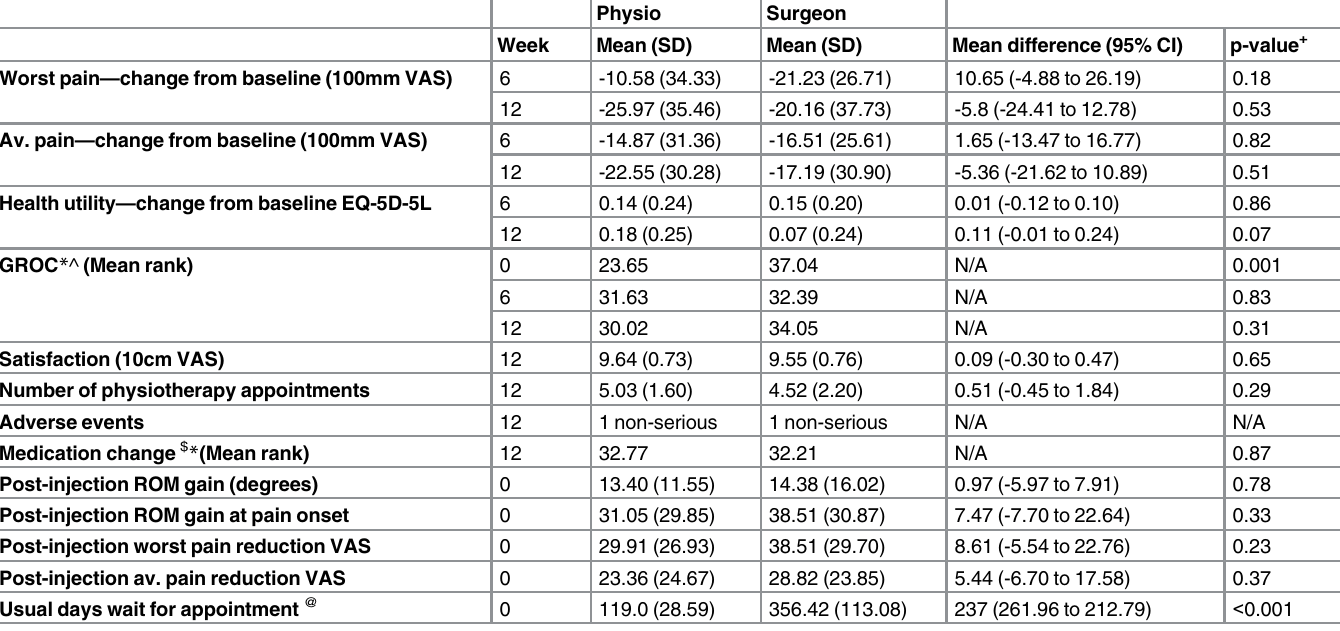
Table 3. Secondary outcome